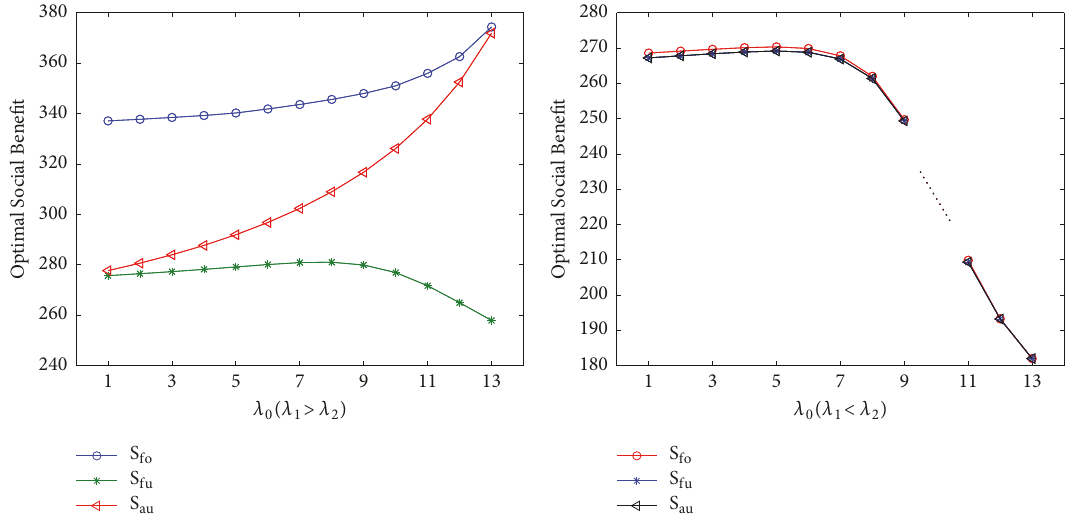
Figure 9: Left: Optimal social benefit under three different information levels vs. 𝜆 0 ( 𝜆 1 > 𝜆 2 ) for 𝑅 = 30, 𝐶 1 = 10, 𝐶 2 = 10, 𝜆 1 = 20, 𝜆 2 = 13, 𝑁 = 15; Right: Optimal social benefit under three different information levels vs. 𝜆 = 15.